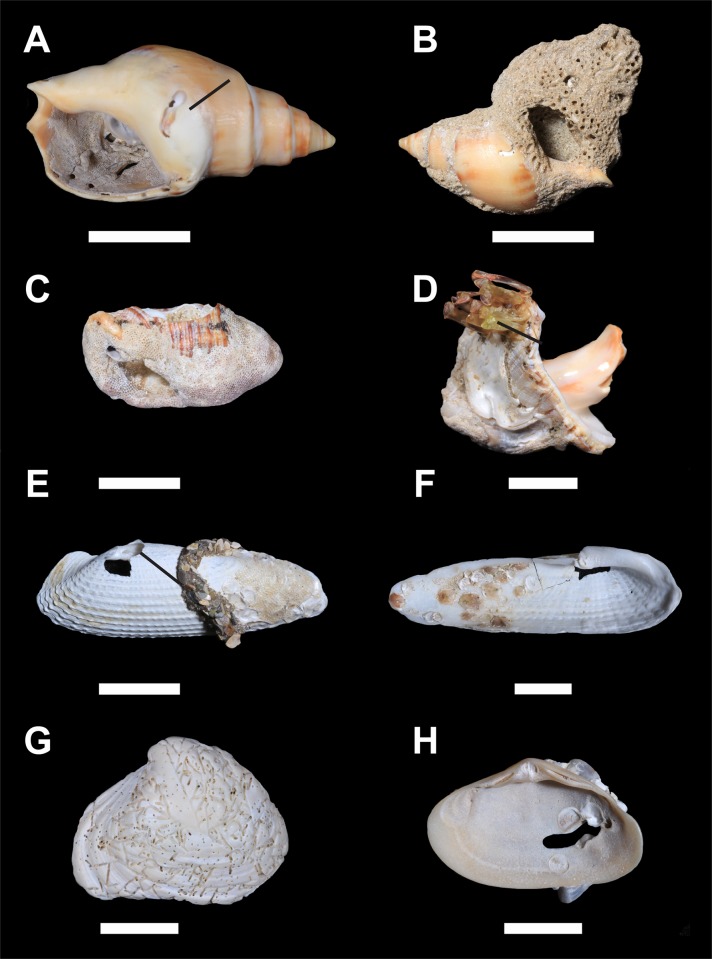
Some examples of sclerobionts that colonized molluscan shells gathered from Concheiros Beach, on the Southern coast of Rio Grande do Sul, Brazil.(A) The inside of a Buccinanops gastropod that contained sclerobionts, such as serpulid polychaete, bryozoans, and an oyster. On the external side of the shell, there is evidence of bioerosion by Spionidea polychaeta (arrow). (B) A gastropod shell with a sand structure made by the polychaete Phagmatopoma caudata. (C) A gastropod covered by bryozoans. (D) A fragment of a gastropod that was fouled by eggs of the bivalve Stramonita haemastoma (arrow). (E) An external view of a Pholas bivalve shell with encrusting Ostreidae and bryozoans and a sediment-tube made by a polychaete (arrow). (F) Internal view of another Pholas shell with several oysters (Ostrea equestris) and bryozoans. (G) External view of an Anadara brasiliana bivalve shell with a boring sponge. (H) Internal view of a Mactra bivalve shell encrusted by Ostreidae. The hole was made by a spionidea polychaete. Scale bars: 10 mm.